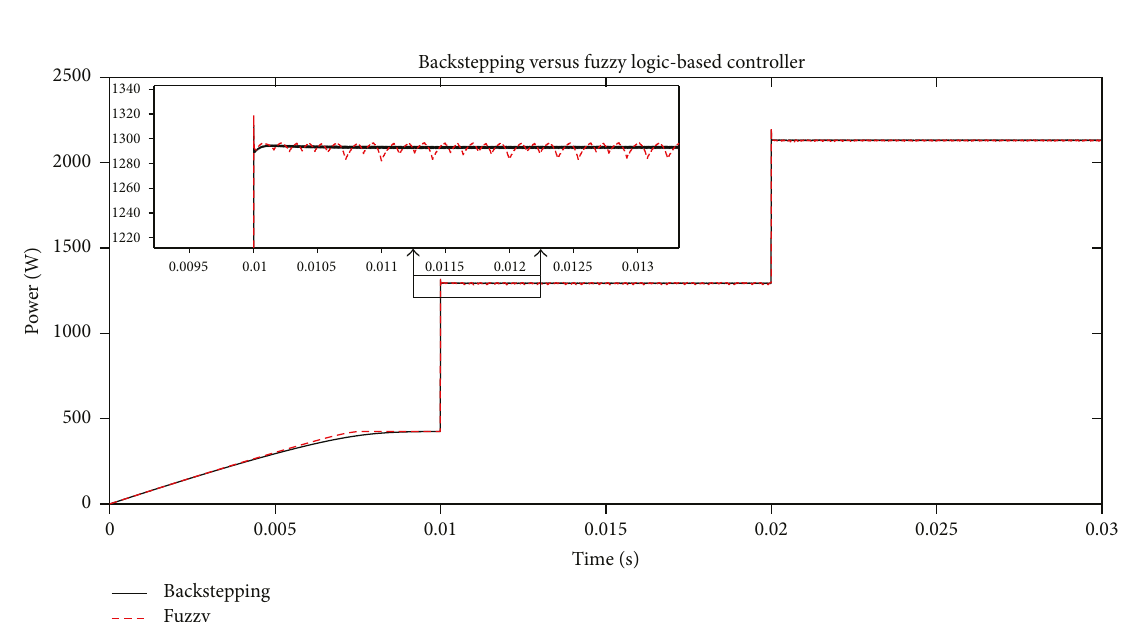
Figure 9: Power comparison under varying temperature.